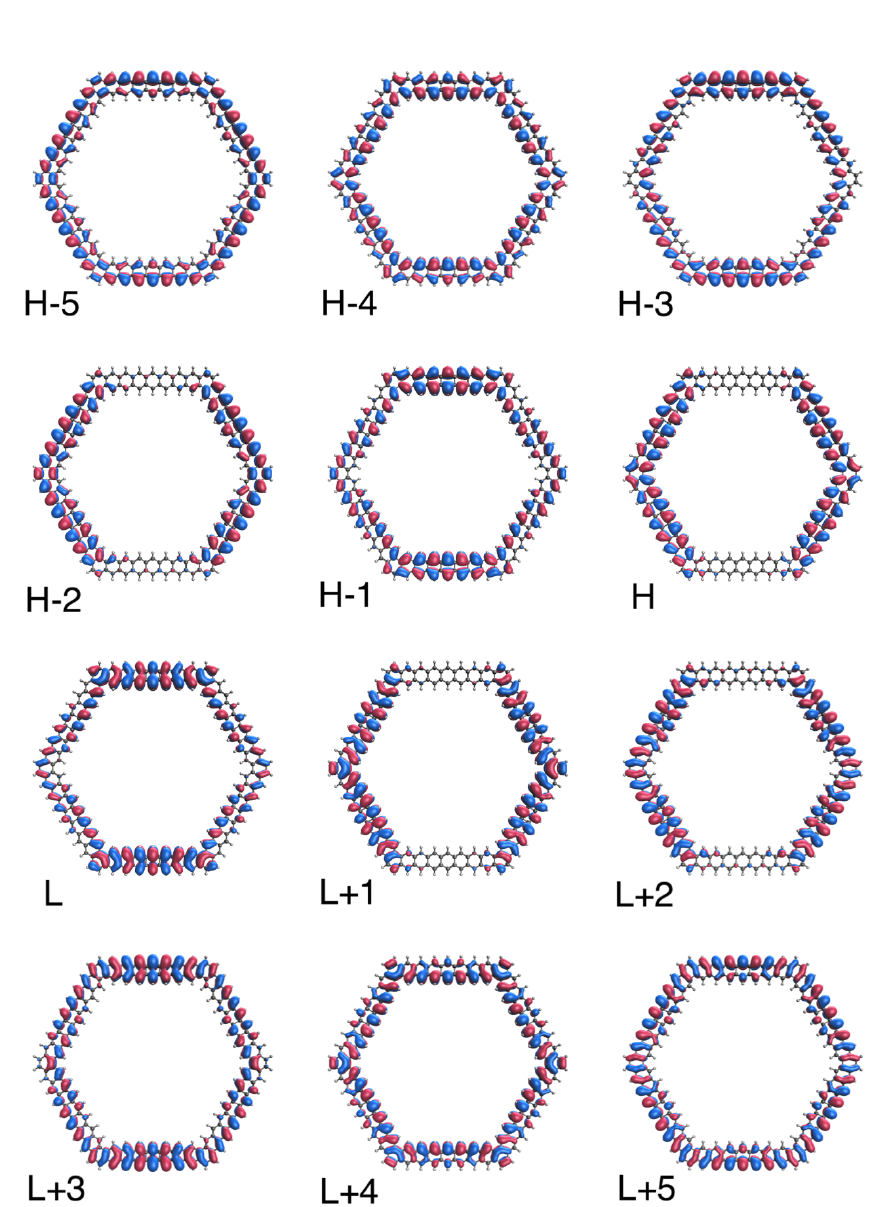
Figure 9. Real-space representation of active TAO-orbitals, such as H − 5 (1.613), H − 4 (1.510), H − 3 (1.504), H − 2 (1.504), H − 1 (1.446), H (1.445), L (0.551), L + 1 (0.551), L + 2 (0.509), L + 3 (0.508), L + 4 (0.486), and L + 5 (0.400) of ground-state 9-HGQR, obtained from spin-restricted TAO-LDA, at isovalue = 0.02 e/Å 3 . The TOONs are given in